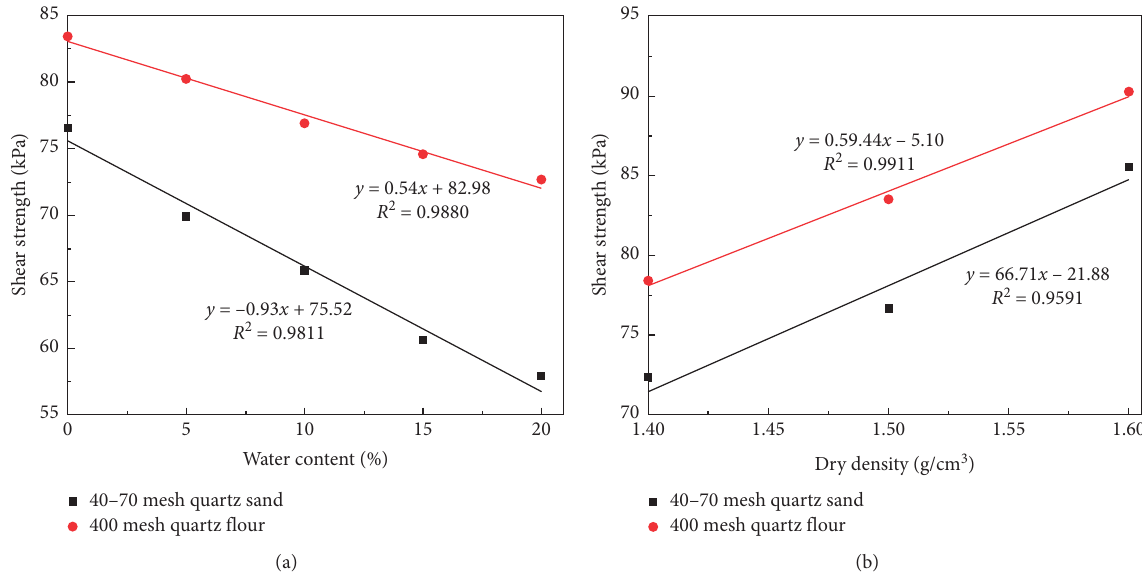
Figure 10: (a) Relationship between water content and shear strength of quartz sand/flour; (b) relationship between dry density and shear strength of quartz